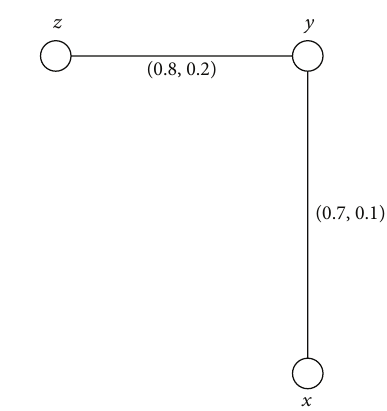
Figure 1: Connected intuitionistic fuzzy